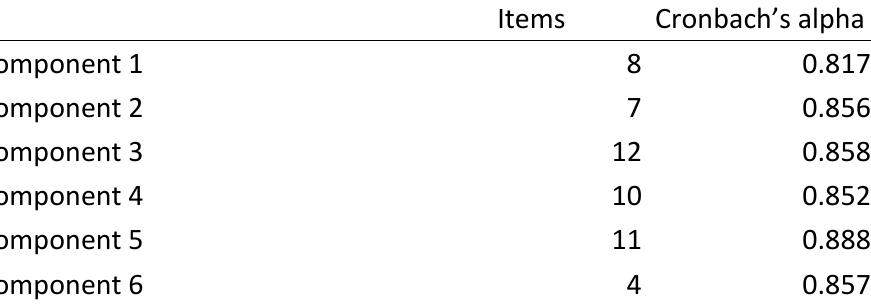
Table 2: Cronbach’s alpha values concerning the first stage of the research.